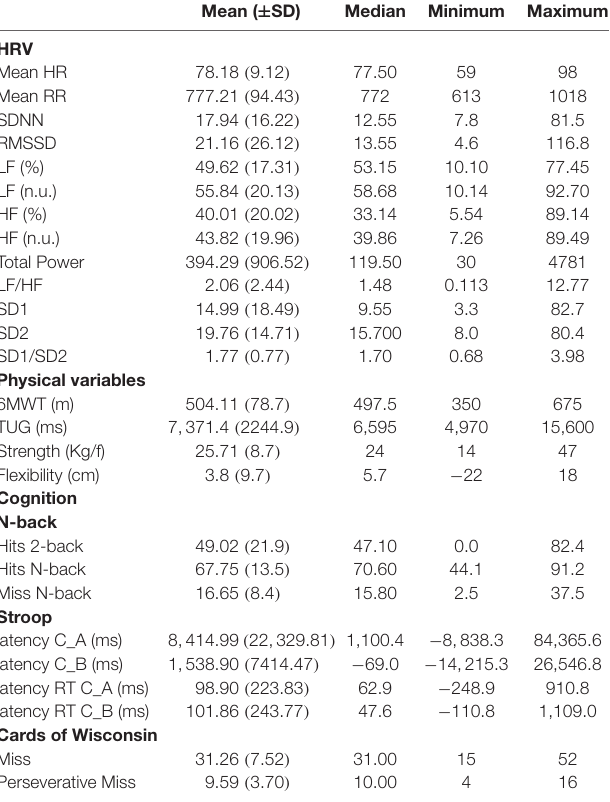
TABLE 1 | Descriptive values of cognitive performance, heart rate variability (HRV), and fitness. Mean ( ± SD) Median Minimum